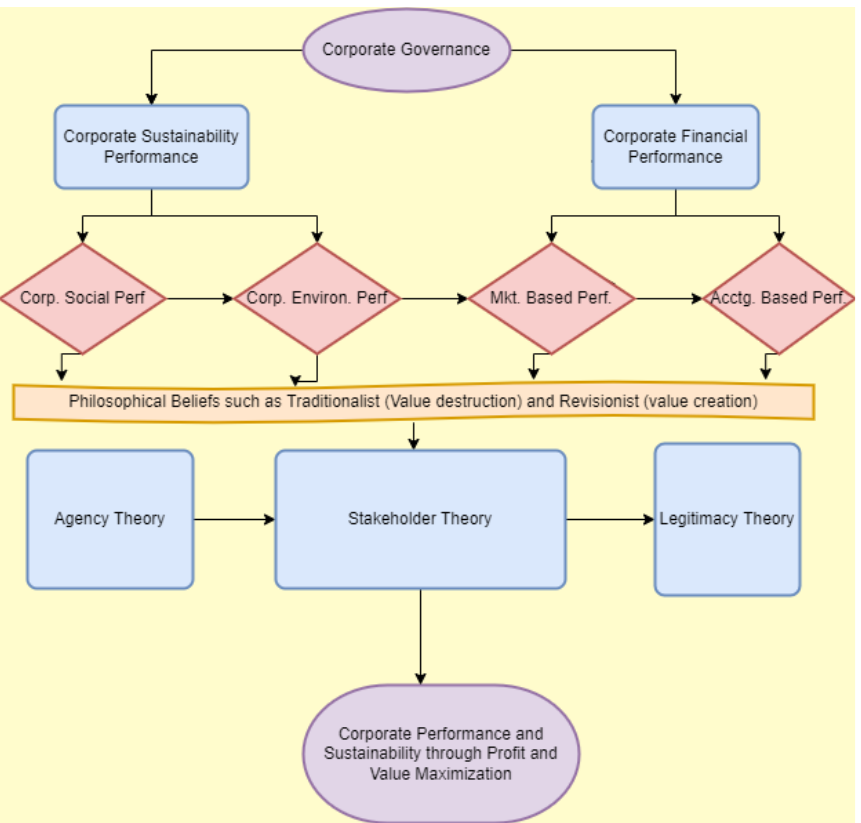
Figure 1: Conceptual and Theoretical Framework showing interactions between Corporate Governance, Corporate Sustainability, and Corporate Performance; Source: